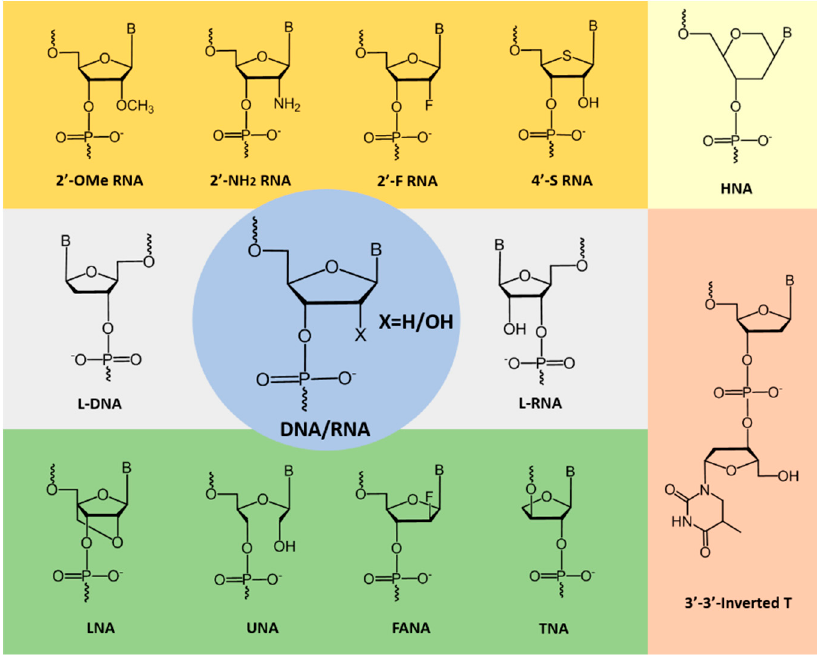
Figure 2. Examples of chemically-modified nucleotides used to improve aptamer stability and kinetics.